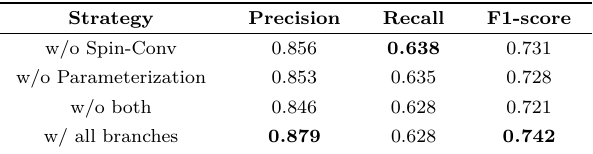
Table 2 Performance of SpinNet when using different rotation angles in spinning convolution. ( ± 20 ◦ , ± 10 ◦ , 0 ◦ ) means that there are